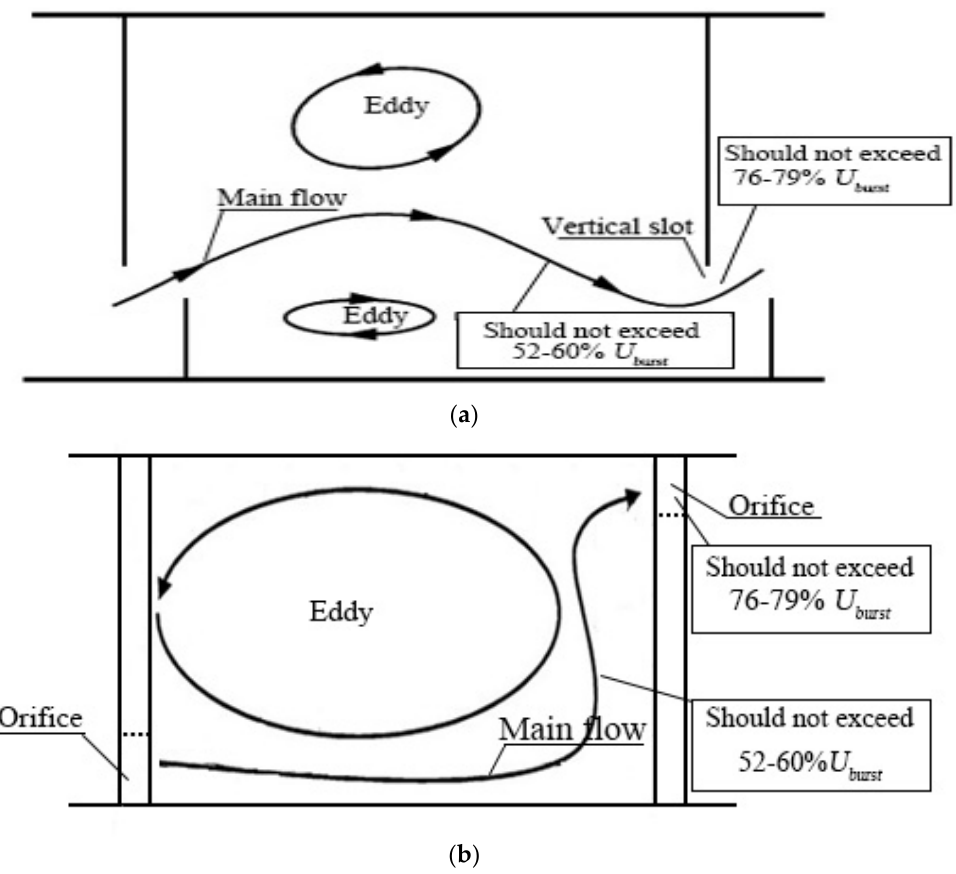
Figure 7. Illustration of typical fishways. ( a ) Vertical slot fishway (adapted from Rodríguez et al. [10]); ( b ) Offset orifices pool type fishway (adapted from Silva et al. [50]).